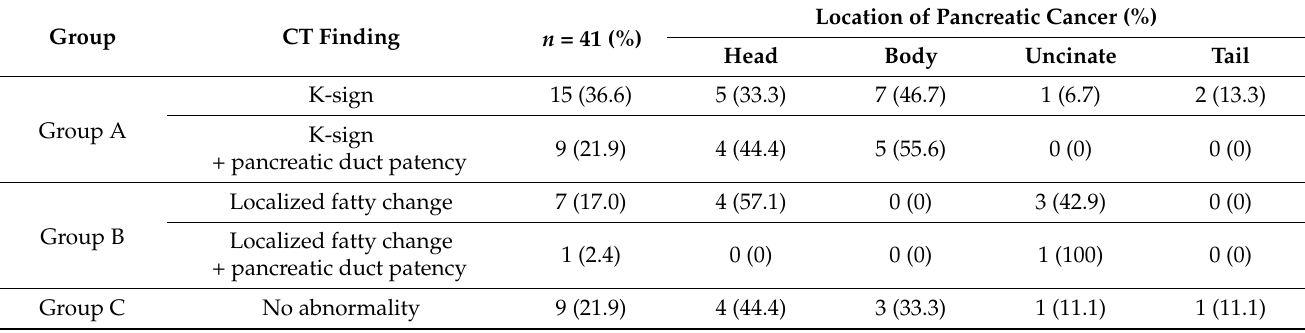
Table 2 . Classification of CT findings.